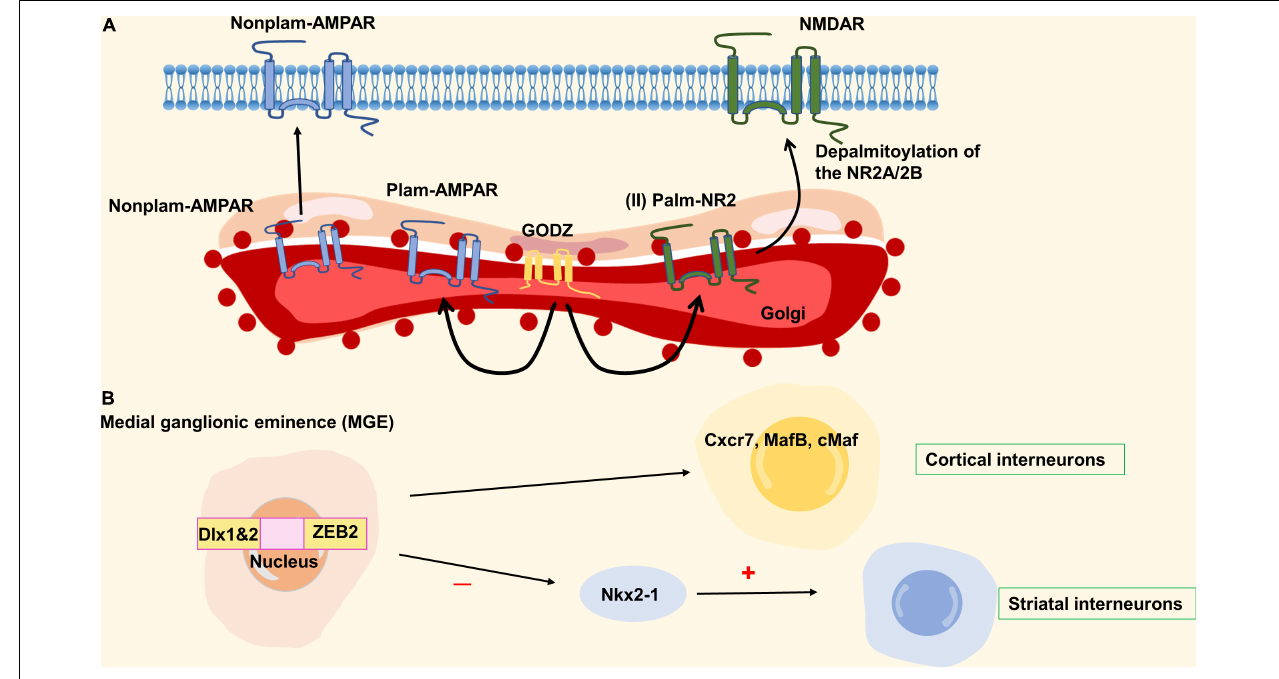
FIGURE 5 | Zinc finger proteins (ZNF) associated with epilepsy. (A) The network of GODZ in epilepsy. (B) The ZEB2 homobox gene produces cortical interneurons expressing cxcr7, mafb, and cmaf downstream of Dlx1&2. When ZEB2 is deficient, Nkx2-1 is not inhibited, and the cells differentiated into cortical interneurons turn into striatum interneurons. ZEB2 is necessary to generate cortical interneurons, and its mutation can cause epilepsy.